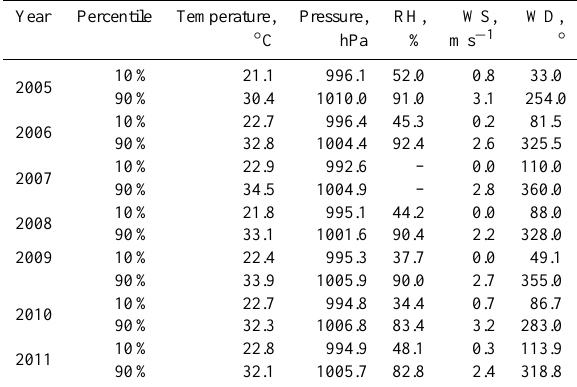
Table 1. Meteorological conditions in August at PKU between 2005 and 2011.